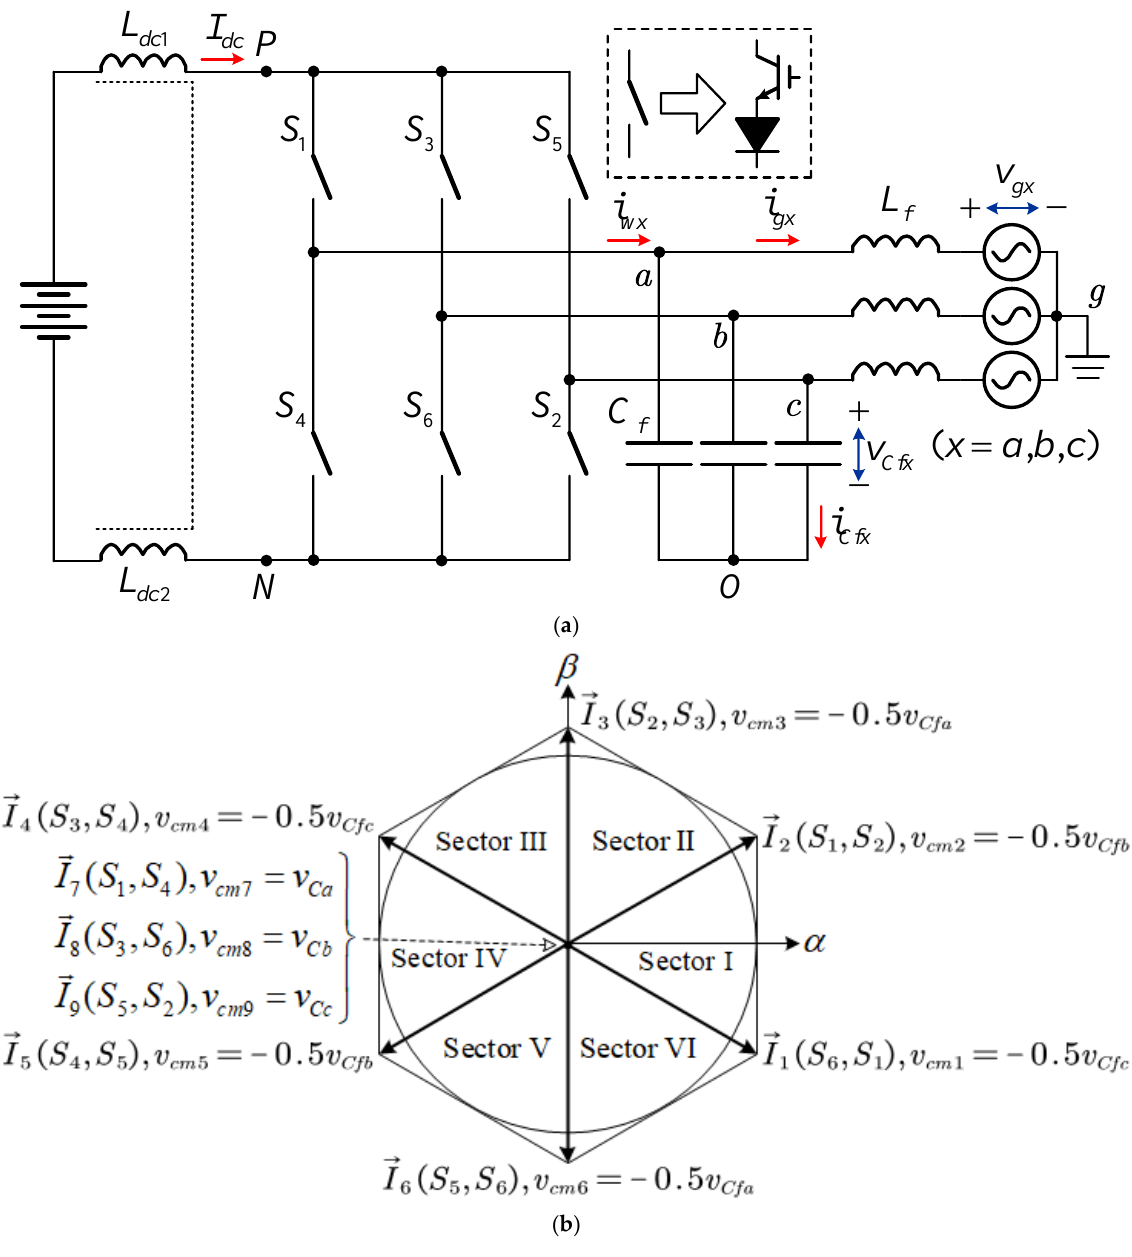
Figure 2. Grid-connected CSI: ( a ) topology, and ( b ) space vector.